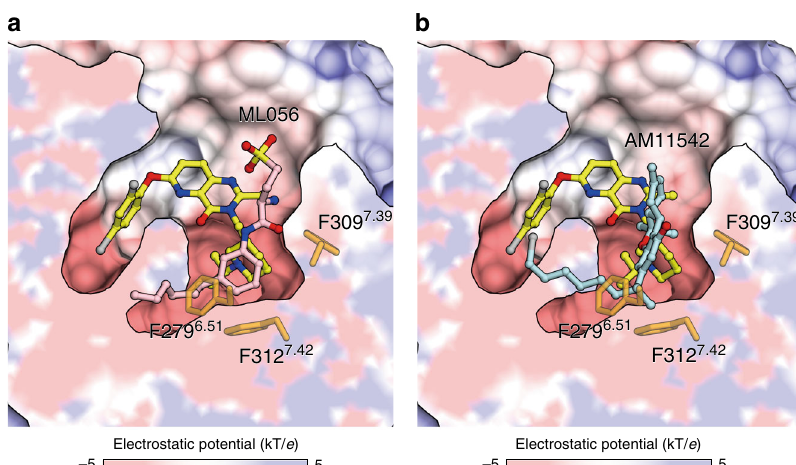
Fig. 5 Comparison of ligand – binding modes of the ghrelin receptor, S1P 1 receptor, and CB 1 receptor. The ghrelin receptor surface and its cross-section were colored according to electrostatic potential from red (negative) to blue (positive) using APBS tools. a The S1P 1 receptor (PDB ID: 3V2Y) and ( b ) the CB 1 receptor (PDB ID: 5XRA) are superposed onto the ghrelin receptor. The 279 6.51 , F309 7.39 , and F312 7.42 of the ghrelin receptor and Compound 21 are depicted as orange and yellow sticks, respectively. The sphingolipid mimic S1P 1 antagonist (ML056) and the CB 1 antagonist (AM11542) are depicted as pink and cyan sticks,